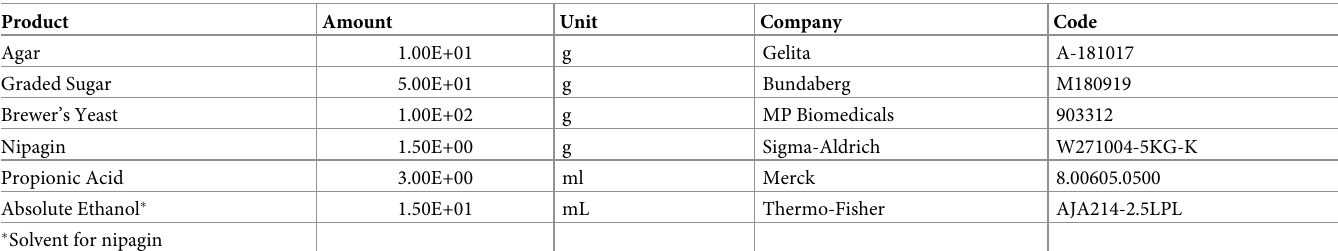
Table 1. Product amounts in 1000mL of Laboratory’s Sugar-Yeast (SY)